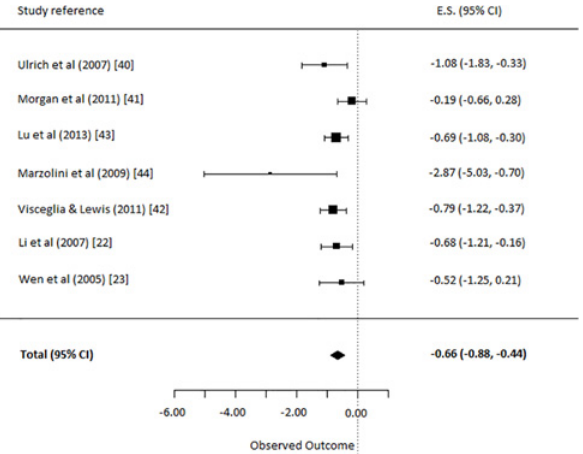
Fig 4. Comparison: depressive symptoms in non-verbal therapy versus treatment as usual.